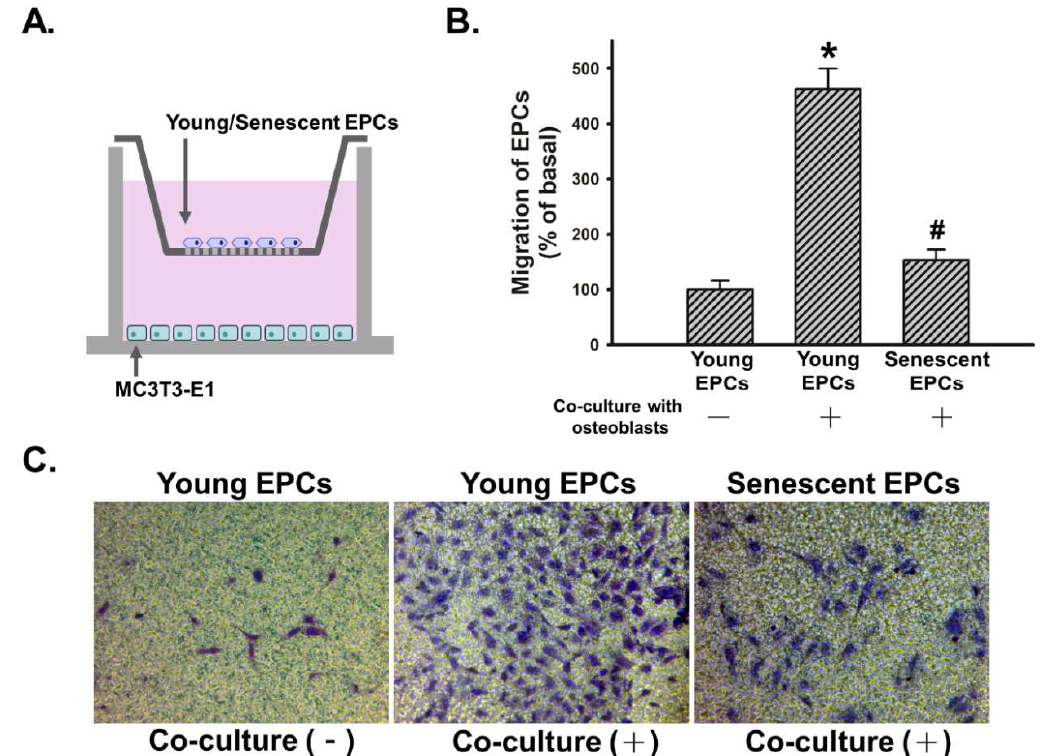
Figure 3. Effect of senescence on osteoblast-attracted EPCs migration. Young and senescent EPCs were seeded onto an upper chamber, then co-culture with or without MC3T3-E1 cells and migration activity of EPCs was measured after 24 h. ( A ) Scheme of transwell co-culture model for EPCs and MC3T3-E1 cells; ( B ) Cells that migrated the filter were counted and quantified ( N = 5) as mean ± S.E.M. * p < 0.05 compared with the basal group (without co-culture). # p < 0.05 compared with the group of young EPCs; ( C ) Representative images of migrated EPCs were shown (phase contrast, 40×).